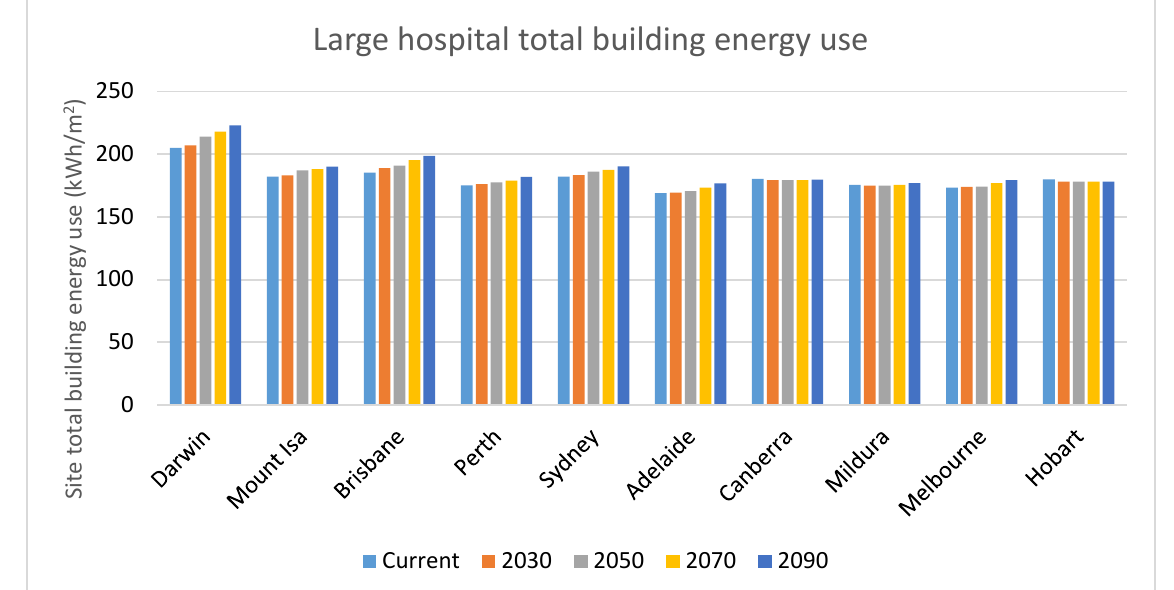
Figure 14. Large hospital’s total building energy use intensities.